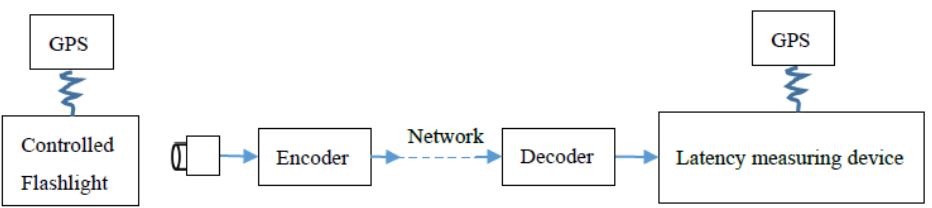
Figure 4. Remote online measurement scheme.